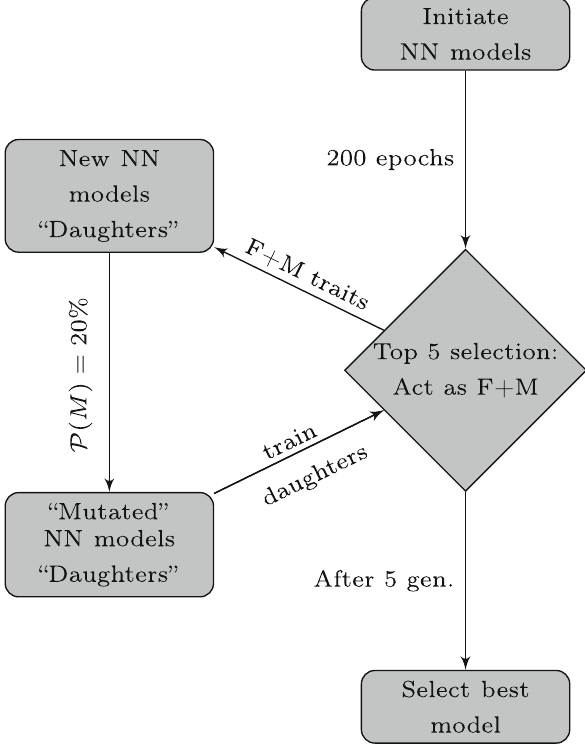
Fig. 4 Flowchart representative of all iterative steps involved in the genetic algorithm that we employ in this